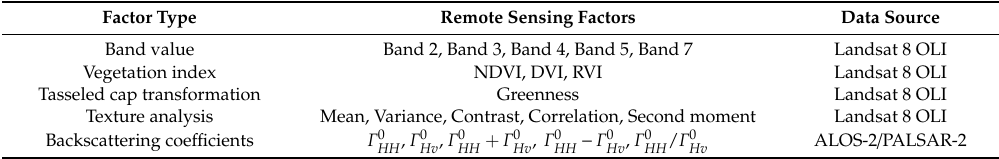
Table 2. Remote sensing factors calculated from the Landsat 8 and ALOS-2 / PALSAR-2